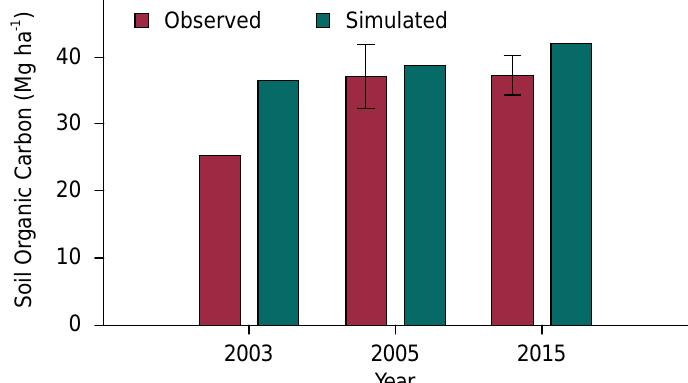
Figure 3. Observed and simulated soil organic carbon (SOC) from flood irrigated rice under a no- tillage system in a long-term experiment in southern Brazil. Error bars represent standard